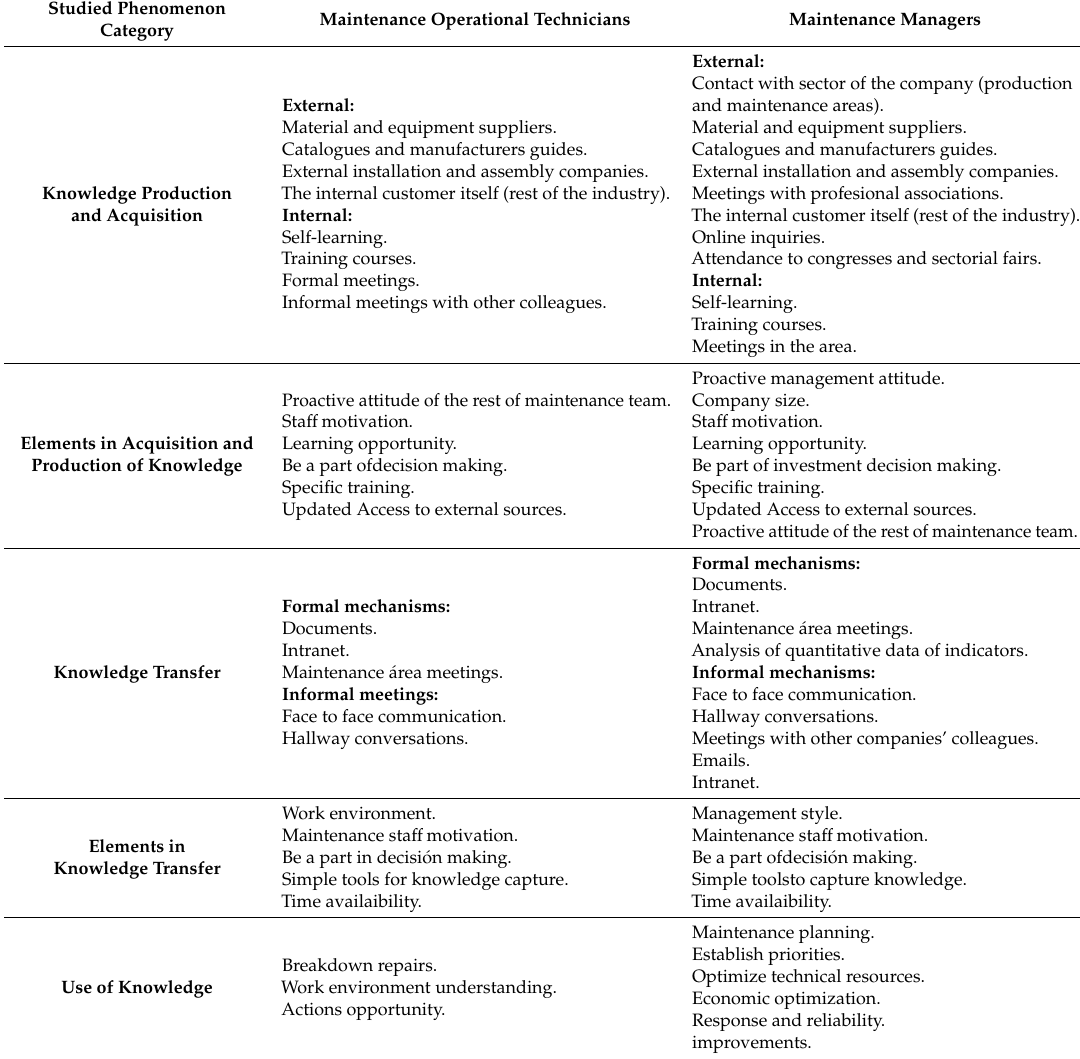
Table 2. Knowledge management (KM) factors observed by their